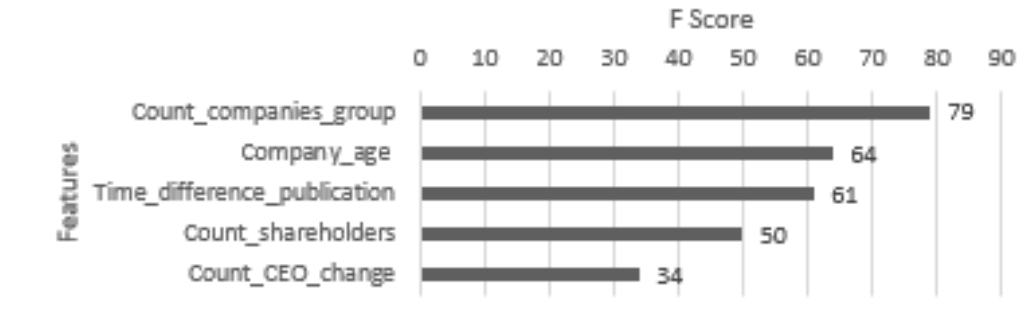
Figure 3. Feature importance (Top 5) based on all available data (F A + F T + F C ).